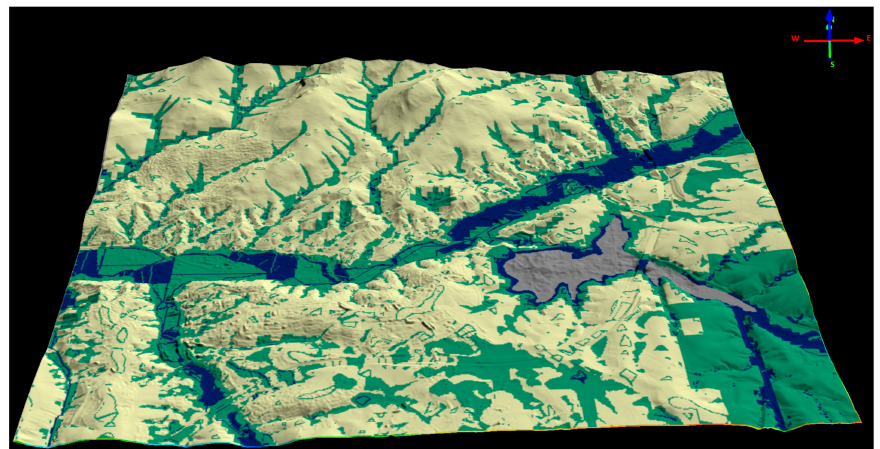
Figure 22. The DTM of the study area textured with the flood susceptibility map (modified into three classes after Sozer et al. [19]).